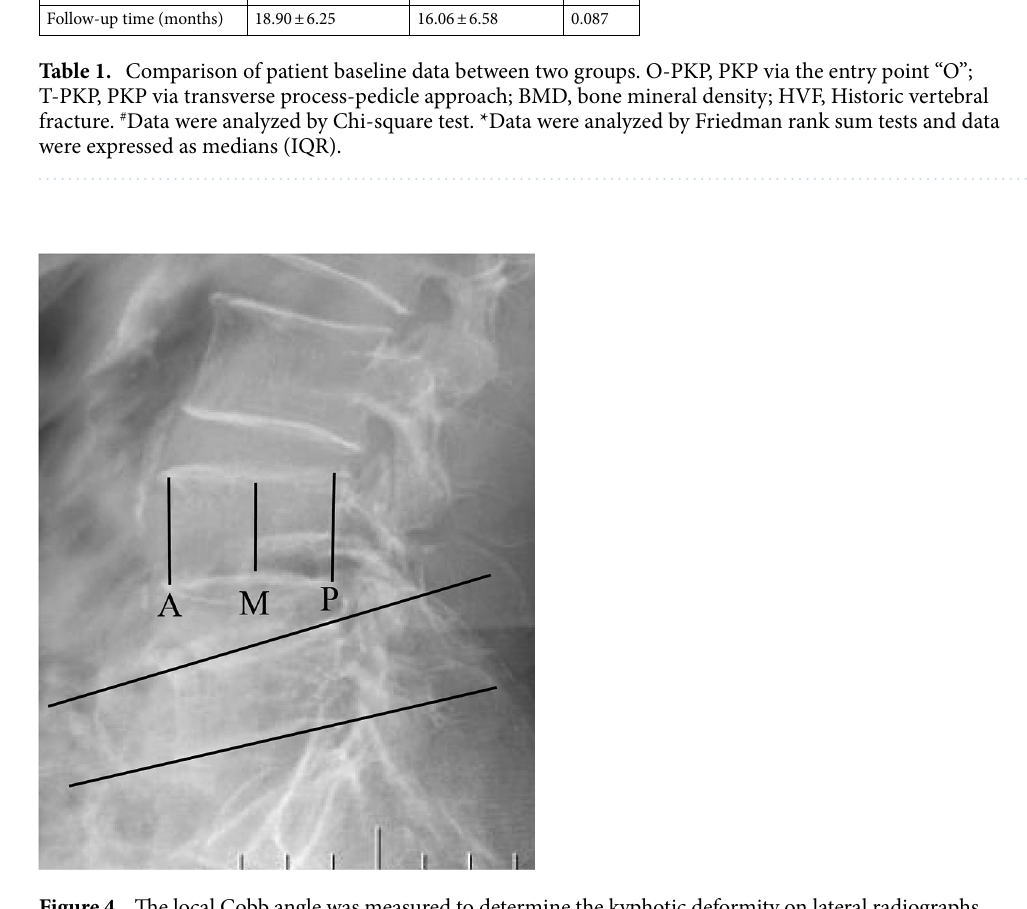
100%. The bilateral distribution on lateral imaging was considered satisfactory only when the bone cement was distributed evenly across the vertebral midline. It was also considered good when the anteroposterior distribu- tion of the bone cement on preoperative imaging was well distributed across the anterior one-third midline of